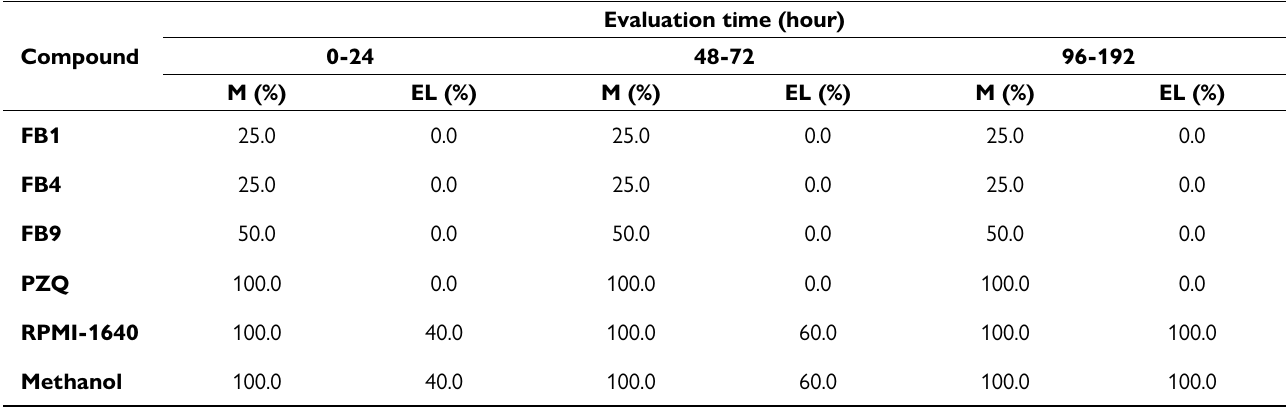
Table 2. Mating (M) and egg laying (EL) of adult worms of S. mansoni after contact with eugenol derivatives FB1, FB4, and FB9 using ED praziquantel (PZQ) at 0.0064 mM.